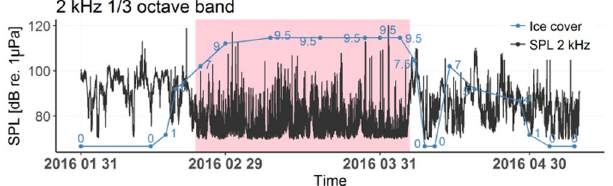
Figure 3. The effect of ice on the measured 2 kHz one-third octave band SPL in the Bothnian Bay BIAS sound monitoring location 11. The ice concentration is a fraction that expresses the sea surface ice cover in one- tenths (1/10). The complete coverage by ice corresponds to 10/10. The pink background highlights the time period when the ice concentration seems to affect the measured sound levels the most. During ice cover a wide selection of ice dynamics driven impulsive sounds is apparent. In this location the ship traffic intensity was relatively low but the recordings still contain the sounds of some ships breaking through ice.